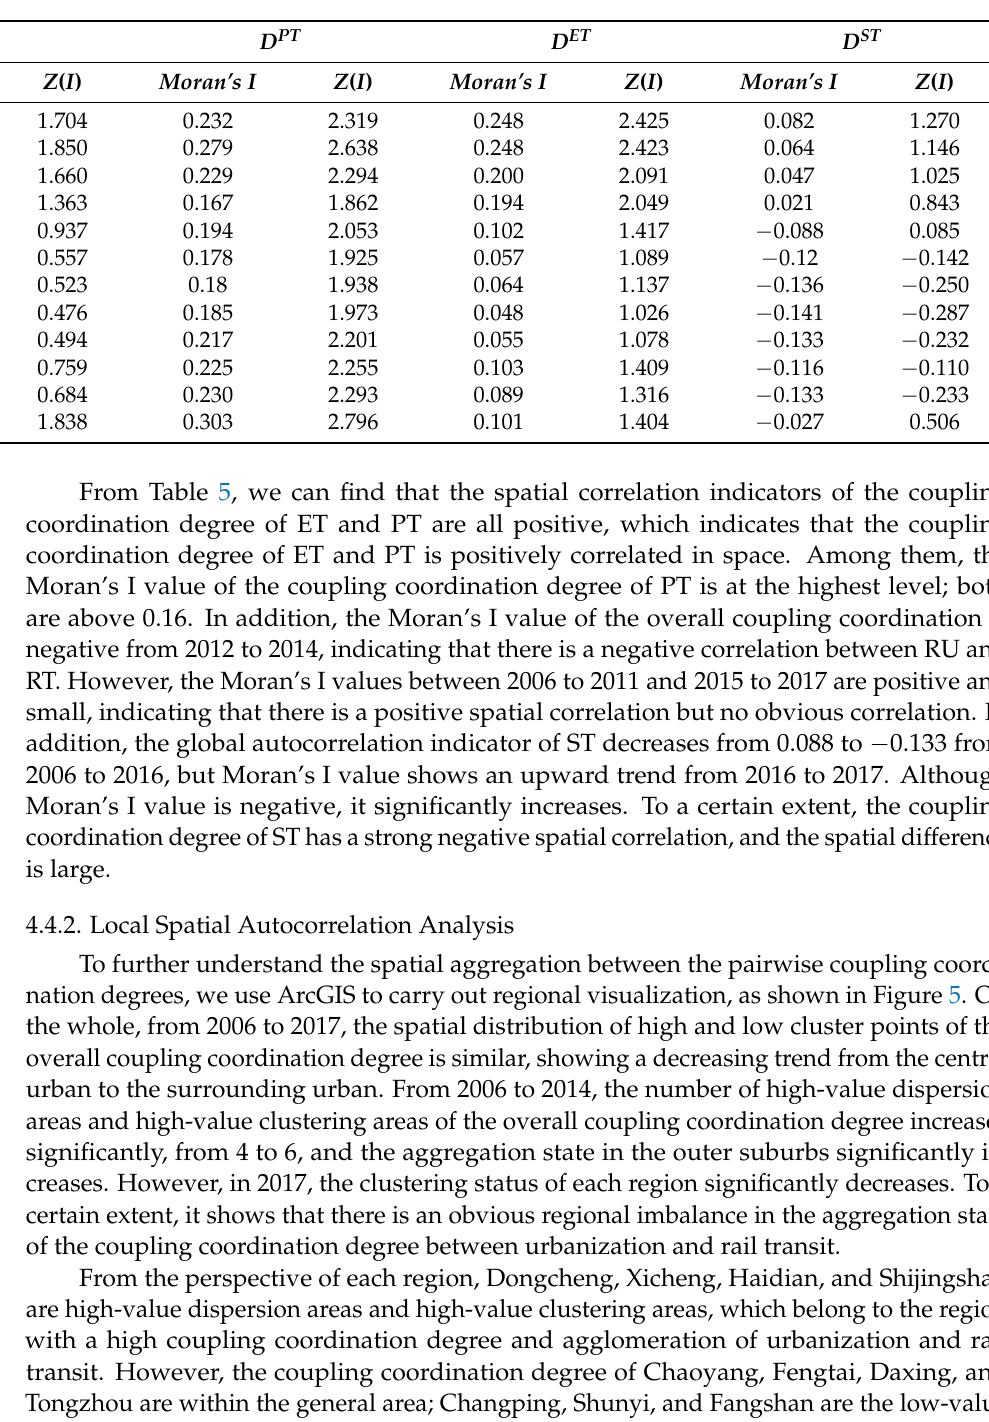
Table 6. The global autocorrelation of coupling coordination